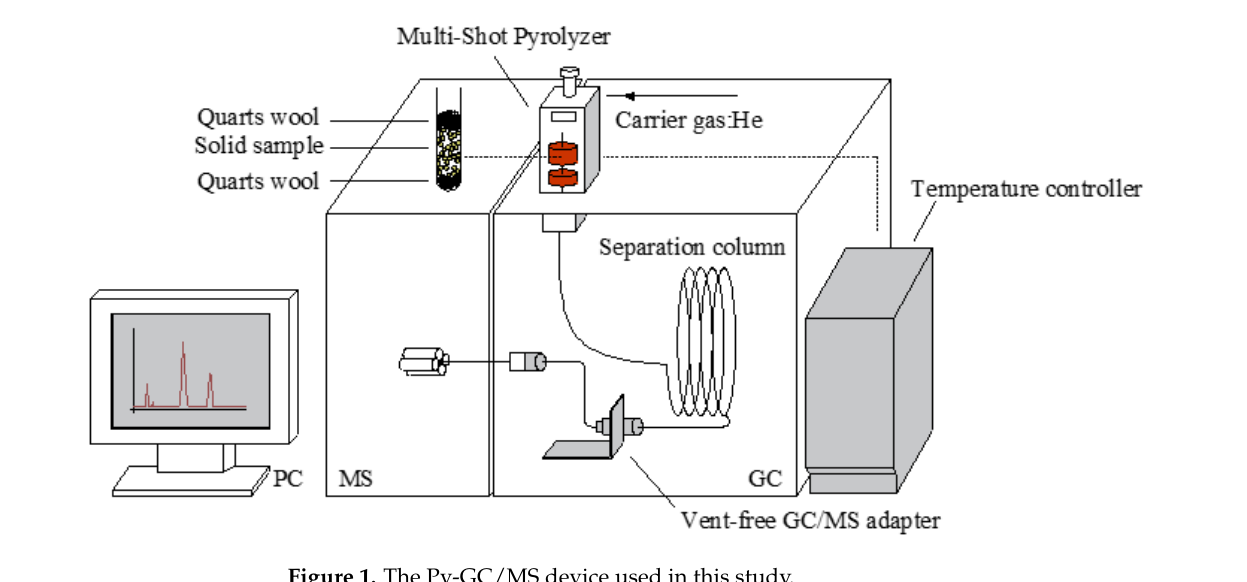
Figure 1. The Py-GC/MS device used in this study.